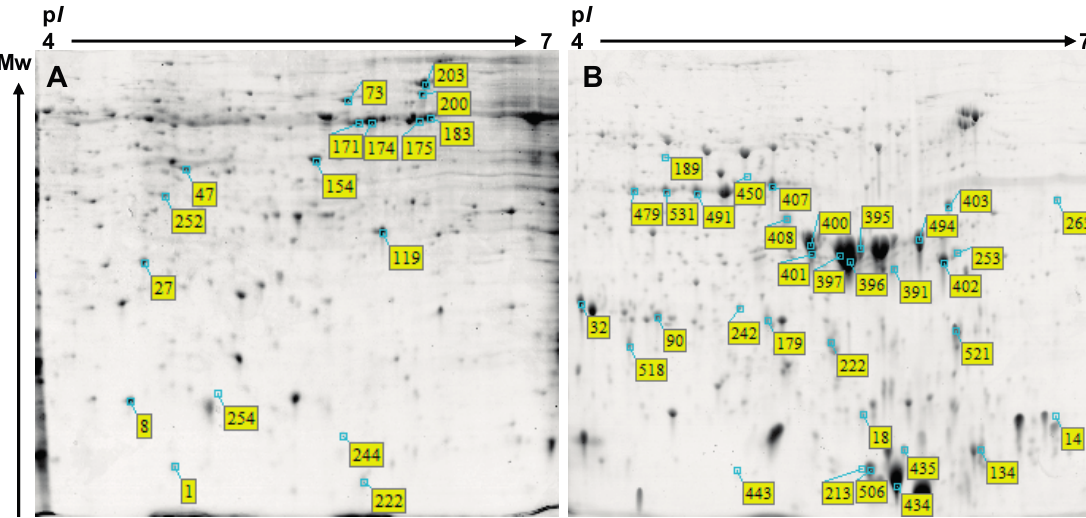
Figure 3. Representative images showing spot identification and localization of proteins extracted from embryos of A. platanoides during morphogenesis ( A ) and maturation ( B ). Proteins that varied in abundance during the period of embryo morphogenesis (10–13 weeks after flowering, WAF) and embryo maturation (14–22 WAF) are indicated by the yellow boxes and blue indicators. Complete information on these proteins is provided in Tables 1, 2 and